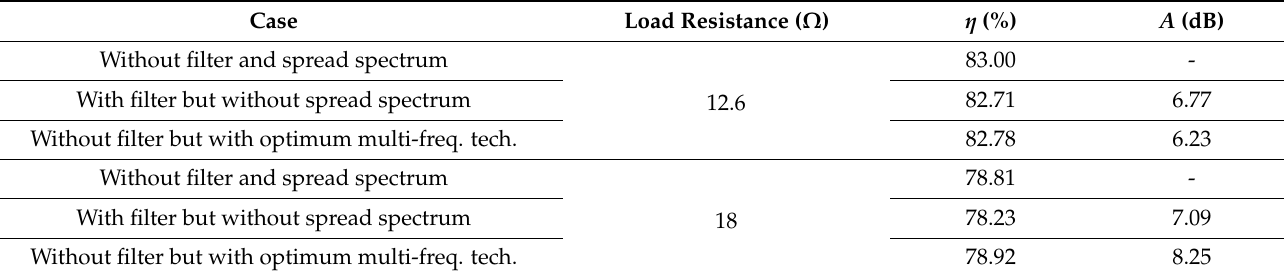
Table 6. Comparison of the measurement results for different cases (coils are aligned perfectly). Case Without filter and spread spectrum With filter but without spread spectrum Without filter but with optimum multi-freq. tech. Without filter and spread spectrum With filter but without spread